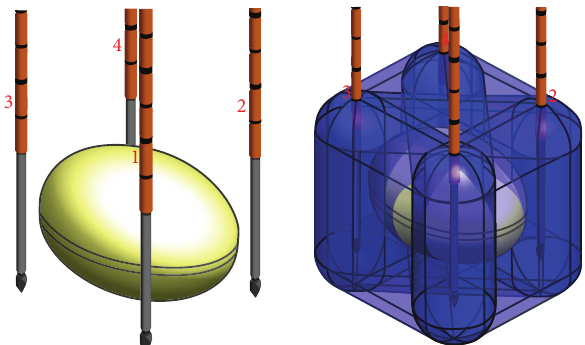
Figure 2: Example of a computerized model of the application of a 4-needle IRE technique. The yellow oval represents the tumor. Crossing blue beams represent the energy developed between each couple of